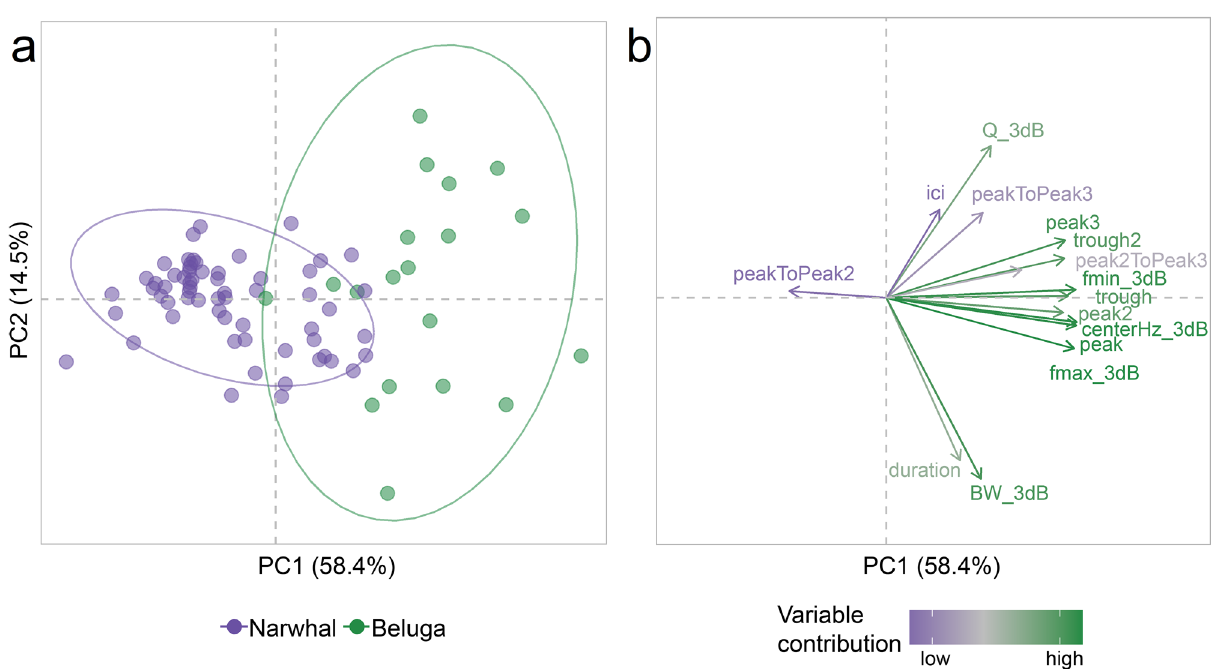
Figure 2. Multivariate PCA ordination plot for beluga or narwhal acoustic events ( a ) and acoustic parameter eigenvectors ( b ). Principle component (PC) 1 explains 58.4% of the variation and PC2 explains 14.5%. The total variable contribution is shown in vector length and color, where purple is a low contribution and green is high. Ellipses in ( a ) show 95% confidence intervals. ( a ) and ( b ) represent the same multidimensional